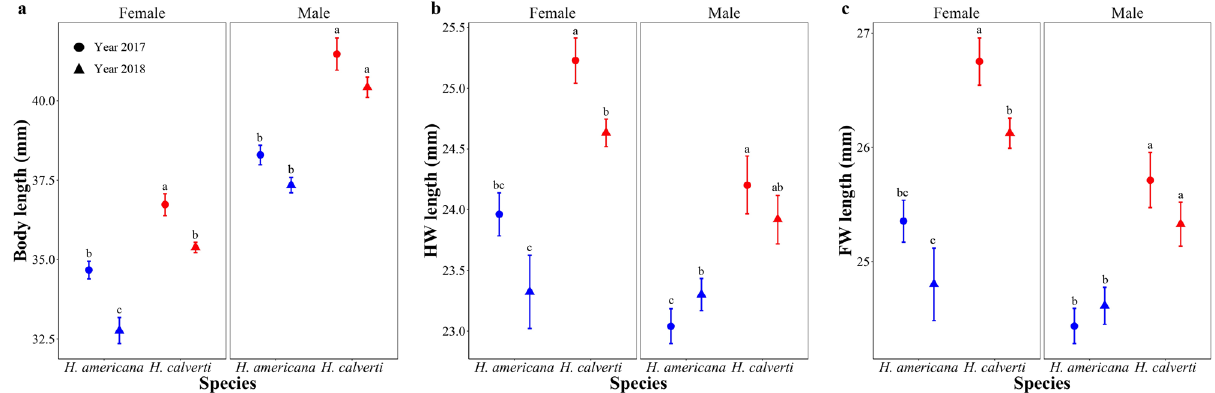
Figure 2. Variation in size between species. Differences in body length ( a ), hind wing length ( b ) and fore wing length ( c ) between species and years of sampling by sex. Means and standard errors are shown, different letters represent significant differences.